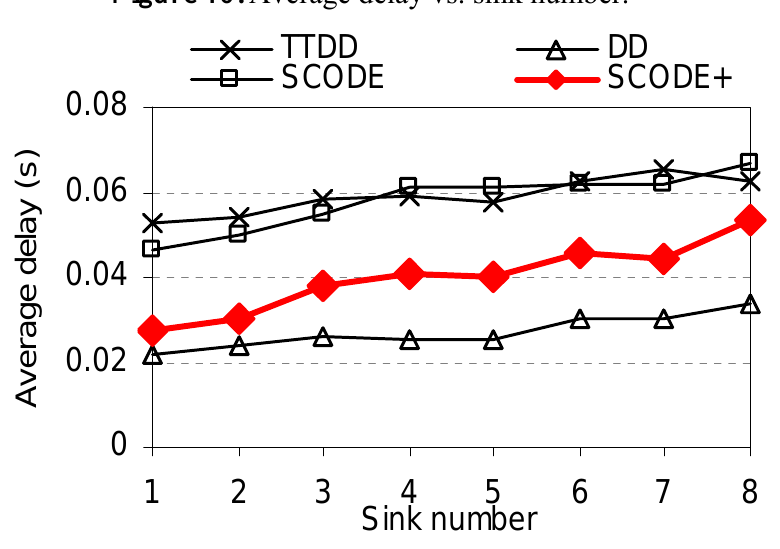
Figure 10. Average delay vs. sink